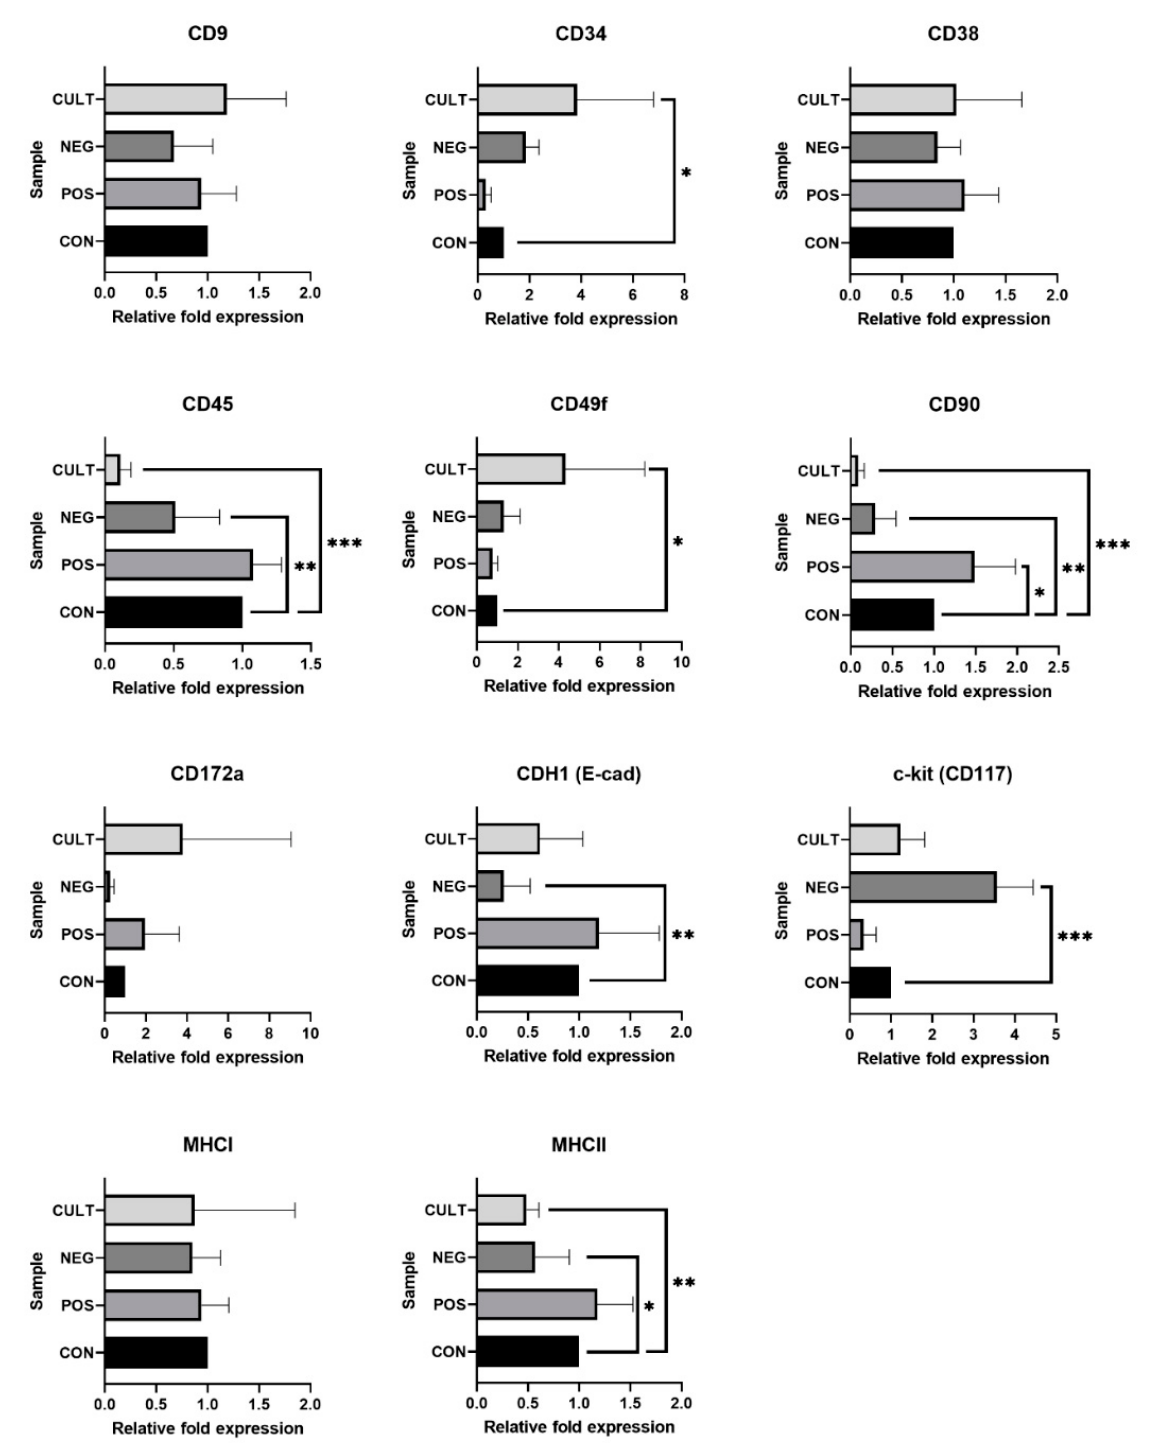
Figure 6. Relative expression of membrane markers analyzed in control (unsorted) samples, sorted fractions, and cultured cells. CON—control sample, NEG—negative fraction, POS—positive fraction, CULT—cultured cells. The data from five experiments are expressed as the mean ± SD; *—difference is statistically significant at p < 0.05; **—difference is statistically significant at p < 0.01; ***—difference is statistically significant at p < 0.001.